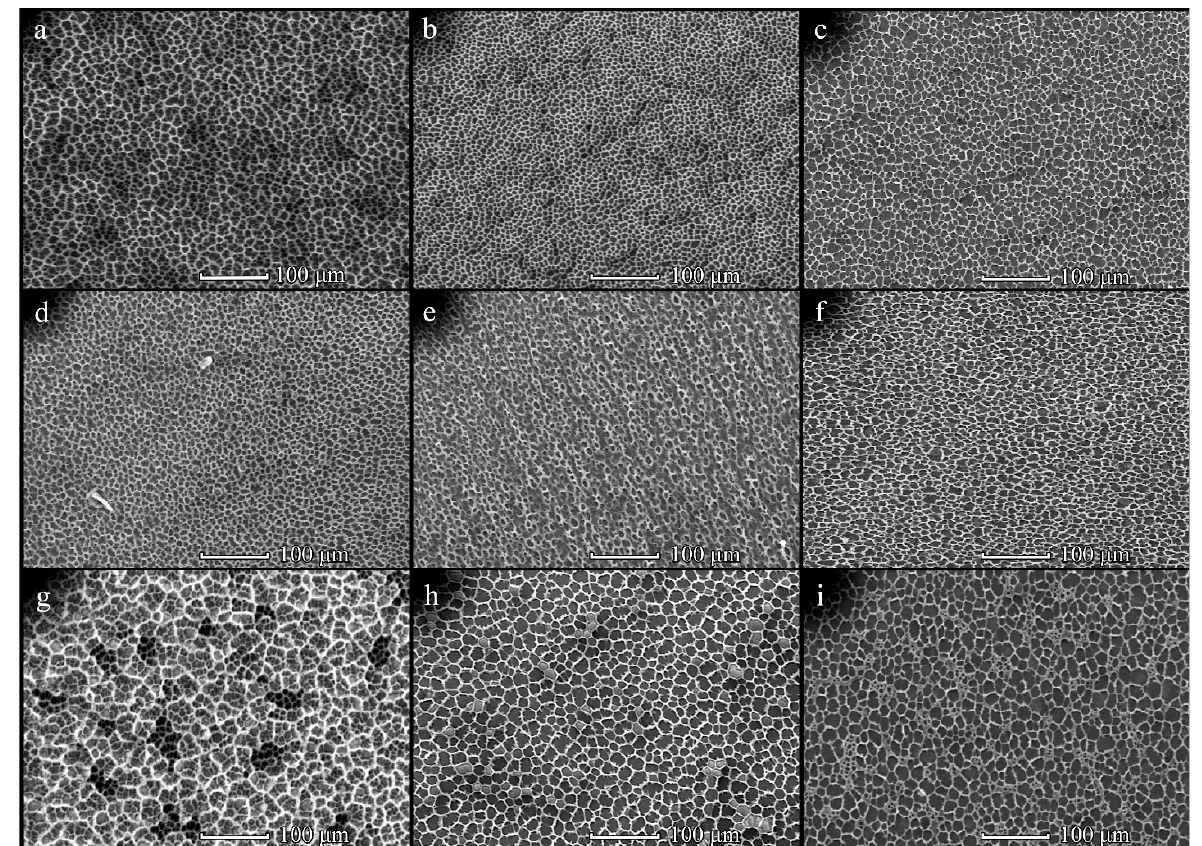
Figure 5. SEM-images of the PHB- co -HV(17%) films obtained from solution with concentration of 10 ( a , d , g ), 20 ( b , e , h ) and 40 ( c , f , i ) mg/mL upon L = 1 cm ( a – f ) and 3 cm ( g – i ). Solution volume is 150 ( a – c ) and 450 ( d – i ) μ L.